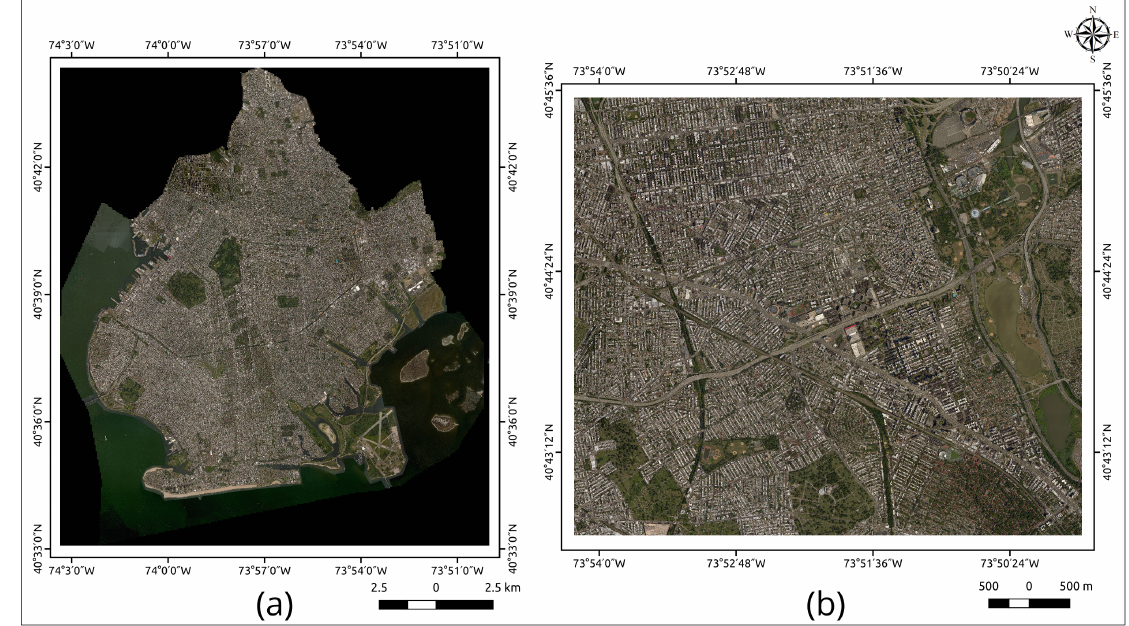
Figure 6. Aerial imagery of the study area in ( a ) Brooklyn borough and ( b ) Queens borough.